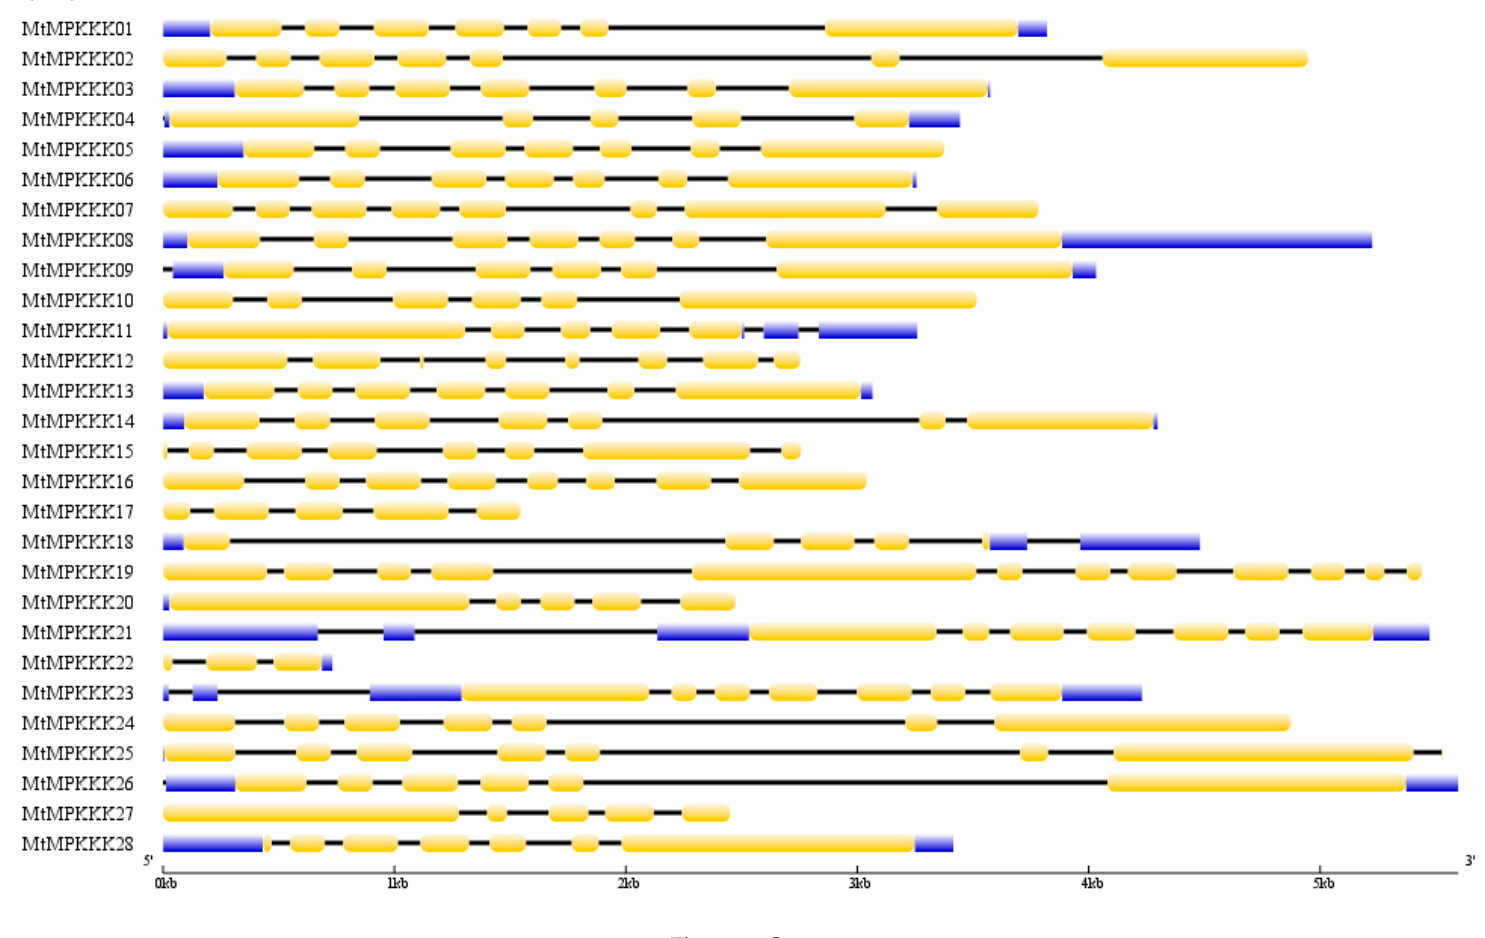
Figure 1. Cont . Figure 1.